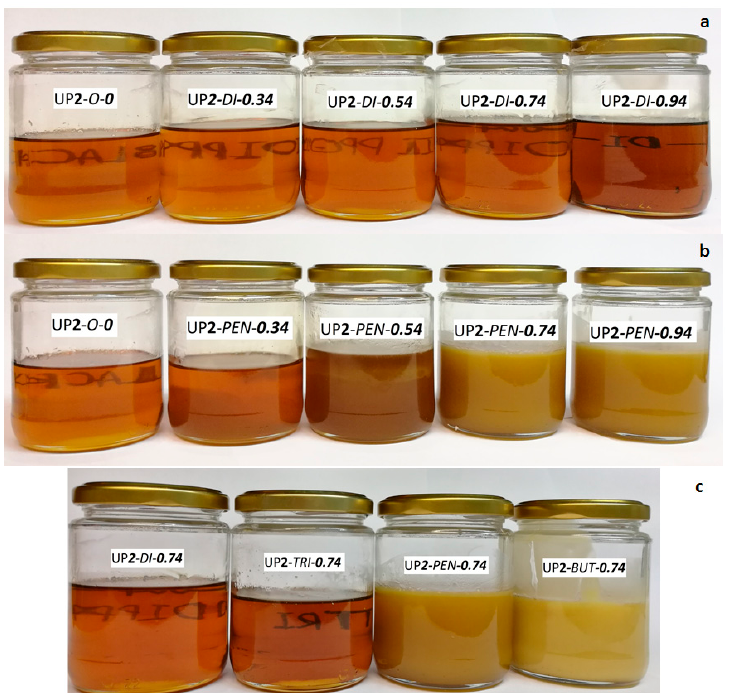
Figure 9. The appearance of samples made in two-stage processing: ( a ) di-PPG chain extended samples compared with the blank sample UP 1 - O - 0 ; ( b ) pentanediol chain extended samples compared with the blank sample UP 1 - O - 0 ; ( c ) samples with a 0.74 molar ratio of different chain extenders.